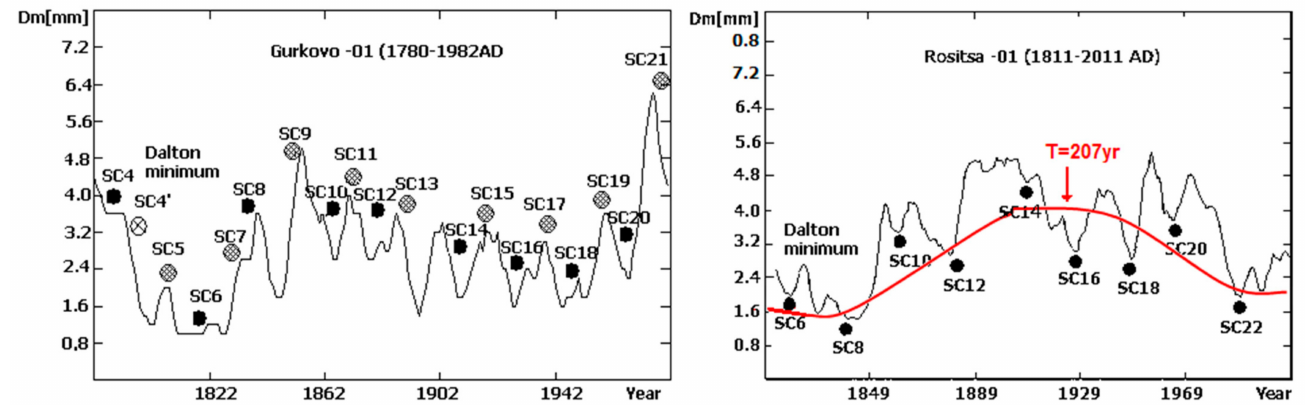
Figure 4. The smoothed 5-year beech annual ring widths series (left: “Gurkovo-01”; right: “Rositsa-01”). The odd numbered Zurich sunspot cycles maxima are marked by gray circles, the even numbered ones–by dark circles; the hypothetic “lost” cycle SC4’ is signed by “ ⊗ ” (see Section 4.2) The Zurich sunspot cycles are signed by “SC” + the corresponding